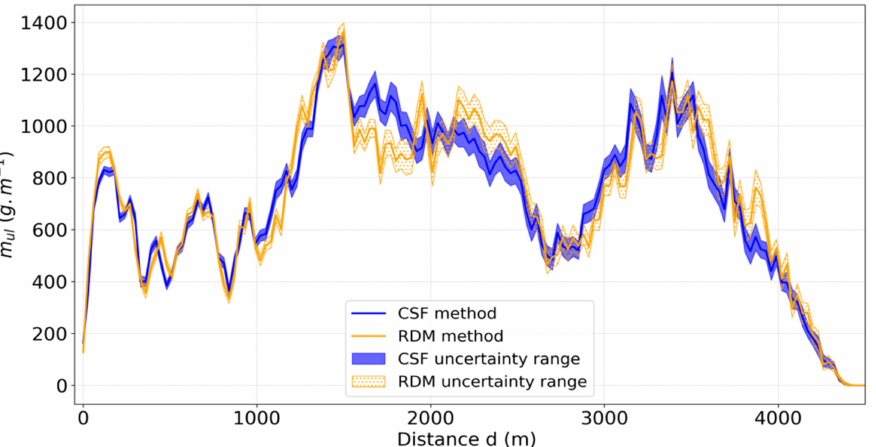
Figure 8. Spatial evolution of the mass per unit length for the Cross-Sectional Flux (CSF) and Rings Decomposition of Mass (RDM) methods for the plume P1. The a posteriori error allows an uncertainty range to be calculated by summing the retrieved concentration and the a posteriori error map.